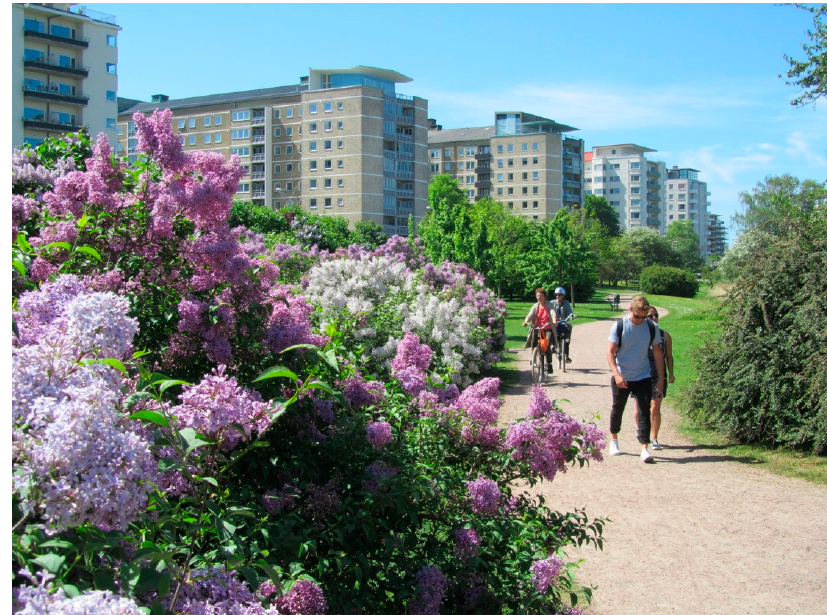
Figure 22. Quality walking and cycling environments in the inner city of Malmö. Source: Jeffrey Kenworthy.